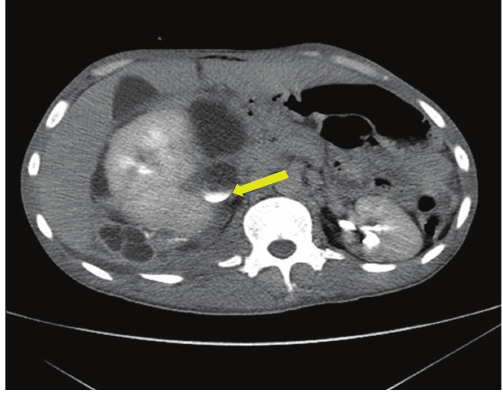
Figure 1: CT scan showing urinoma, contrast extravasation (arrow) with a right pelvicaliceal dilatation.